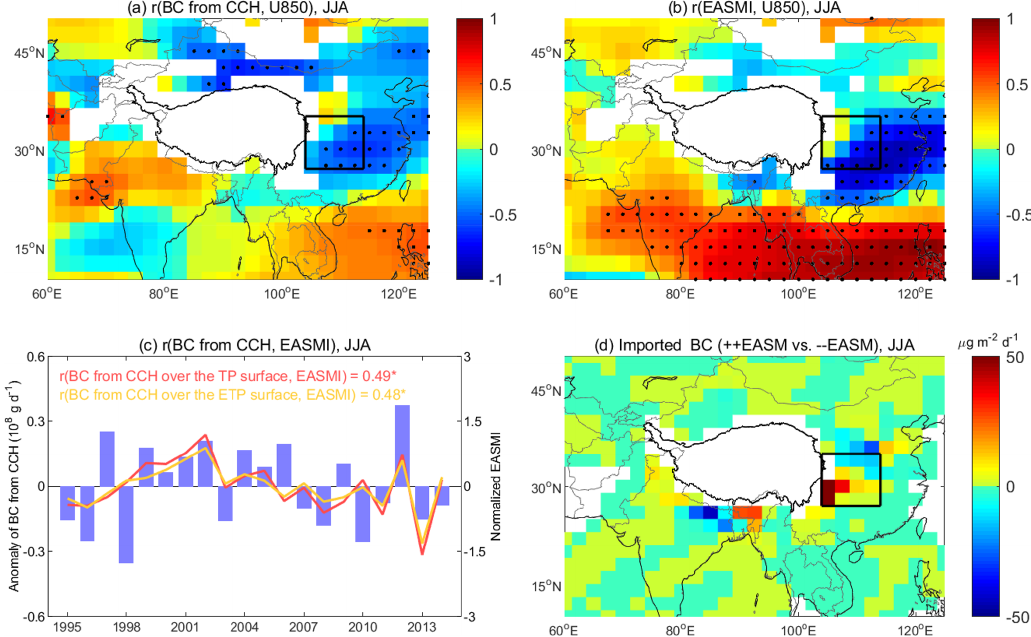
Figure 9. Connection between BC transport from East Asia to the TP surface and the EASM in summer. (a) Correlation coefficients ( r ) between the zonal wind at 850hPa (U850) and imported BC from central China (CCH) over the TP surface; (b) r between the EASMI and U850; (c) inter-annual variations in the intensity of the EASM and imported BC from CCH to the surface of the TP and eastern TP (ETP); (d) differences in BC transport to the TP surface between the years with strong and weak EASM. Dots in (a) and (b) indicate that the r in the corresponding grid is statistically significant ( p < 0 . 05). The unfilled grids in (a) and (b) are due to the topography. An r with “*” in (c) indicates that the r is statistically significant ( p < 0.05). Boxed areas in (a) , (b) , and (d) indicate CCH (see Fig. 4b). The dark black line in (a) , (b) , and (d) encloses the domain of the